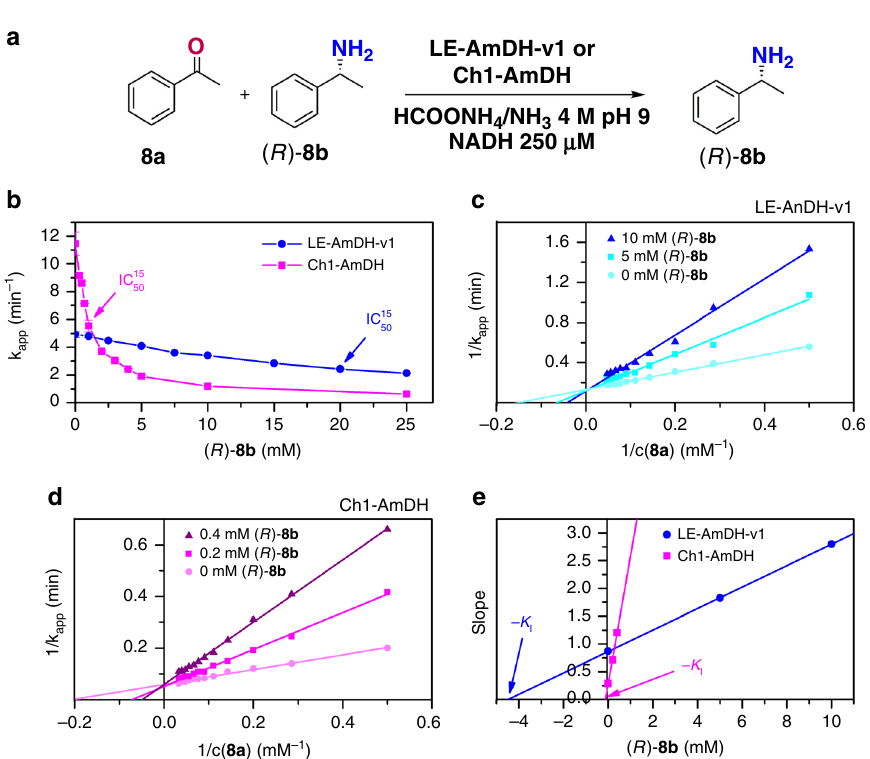
Fig. 4 Product inhibition studies employing LE-AmDH-v1 and Ch1-AmDH. a Overall scheme of the kinetic experiments, in which 8a is used as substrate and ( R )- 8b as competitive inhibitor. b Inhibitory effect (IC 50 15 ) of the amine product ( R )- 8b at 15 mM of substrate concentration 8a . c and d Primary double reciprocal plots for competitive inhibition according to Lineweaver-Burk analysis for LE-AmDH-v1 and Ch1-AmDH, respectively. e Secondary plots of the slopes obtained from the primary Lineweaver-Burk plots vs. inhibitor concentrations. The absolute value of the intercept with the x -axis provides the competitive inhibition constant ( K I ).Source data are provided as a source data fi le. Data points of Fig. 4b are the average of n = 2 independent measurements, but the deviation is so low that the error bar is smaller than the dots; the only visible error bar is for the pink line at k app ca. 5. Figure 4c, d are based on single measurements. Figure 4e is a secondary plot derived from Fig. 4c, d